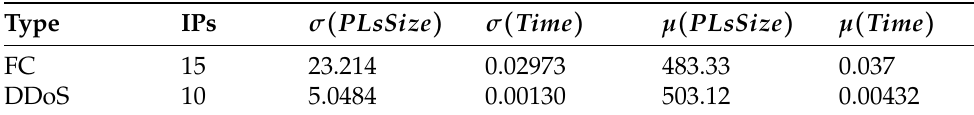
Table 7. Parameters calculated for attack and FC.